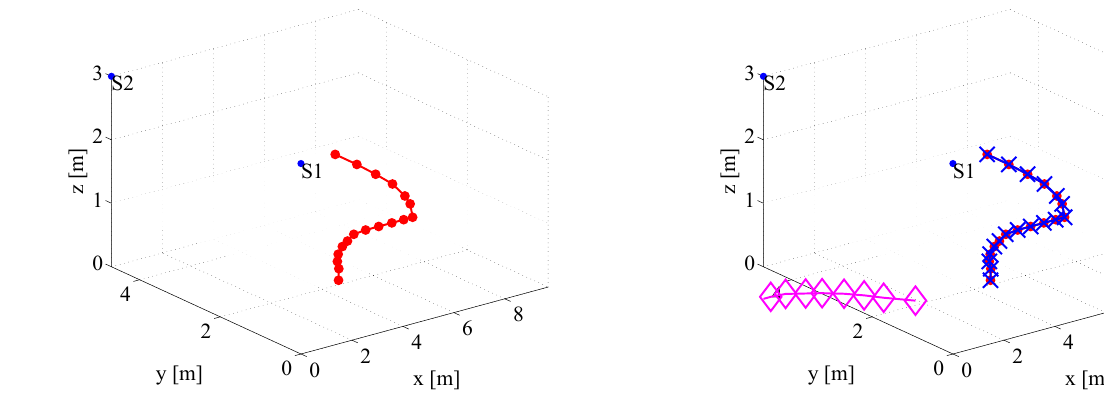
Figure 2. Simulation I: reconstruction of the path when receivers S1 and S2 are located along the y axis at the corners of the ceil- ing of the room. Estimated paths denoted by × and (cid:5) represent the accepted and rejected path of the transmitter,